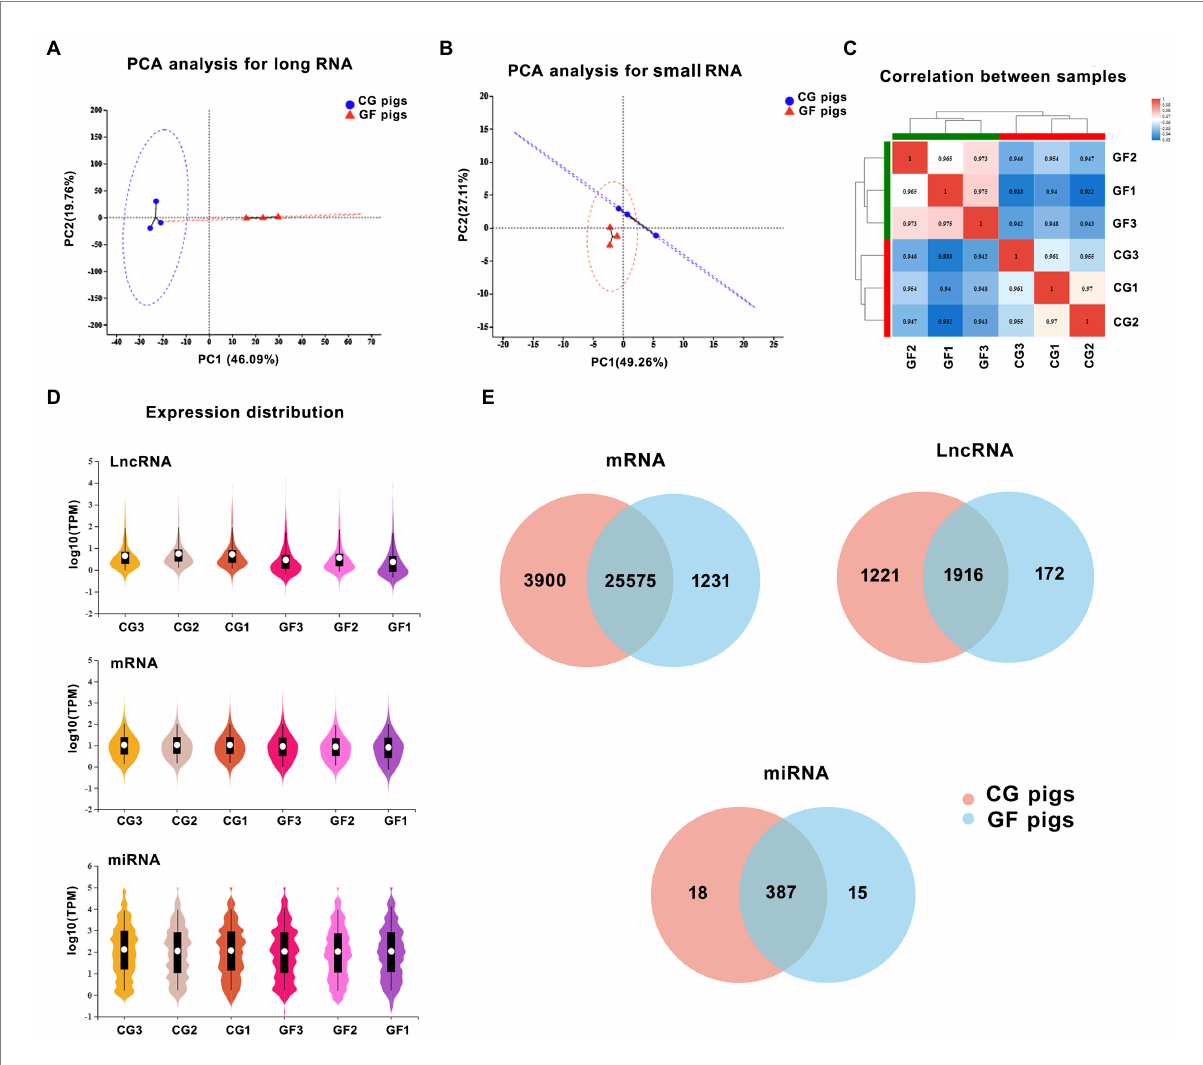
FIGURE 1 The features of the expression of long noncoding RNAs (lncRNAs), mRNAs, and microRNAs (miRNAs). (A) Principal component analysis (PCA) of two groups of samples based on the expression of long RNAs. (B) PCA of two groups of samples based on the expression of small RNAs. (C) The correlation analysis of samples. (D) The total expression levels of mRNAs, miRNAs, and lncRNAs between groups. (E) The number of identified lncRNAs, mRNAs, and miRNAs in the hypothalamus of the two groups of